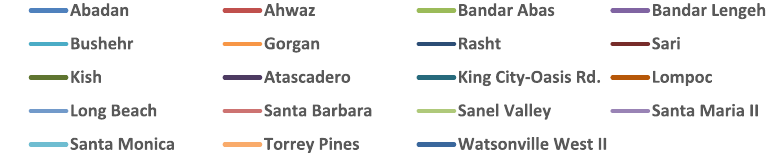
Fig. 8 Mean of temperature based on 365 days from various